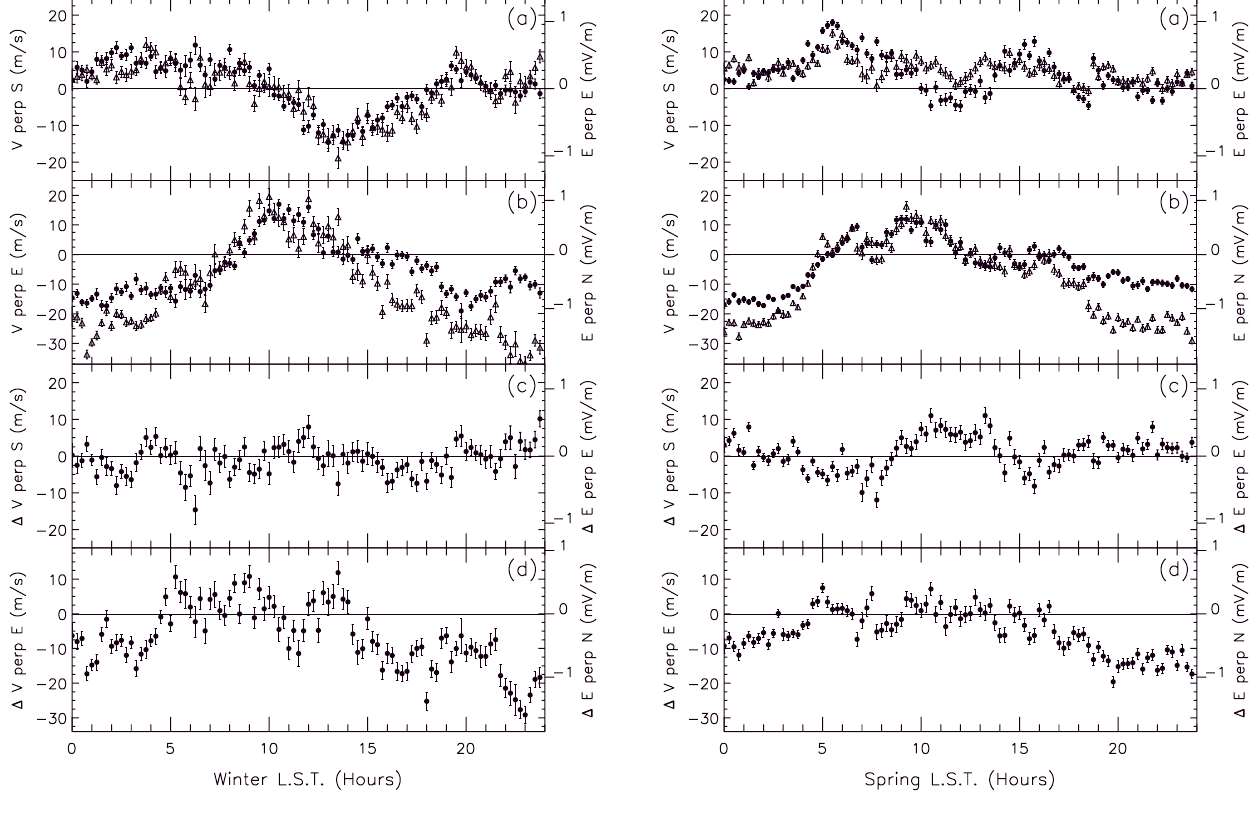
Fig. 5. The same results as Fig. 3 except for winter. Fig. 6. The same results as Fig. 3 except for